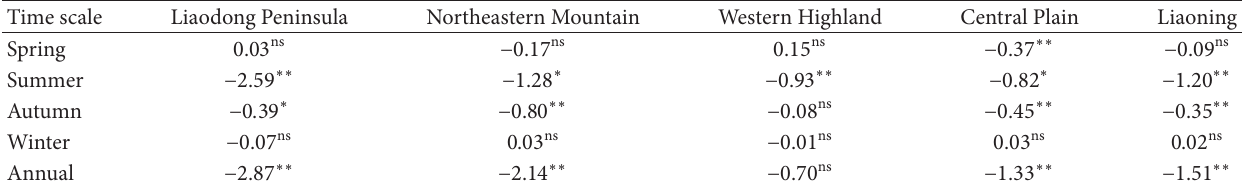
Table 3: Regional Kendall slopes for Liaoning precipitation and its four subregions at different time scales.